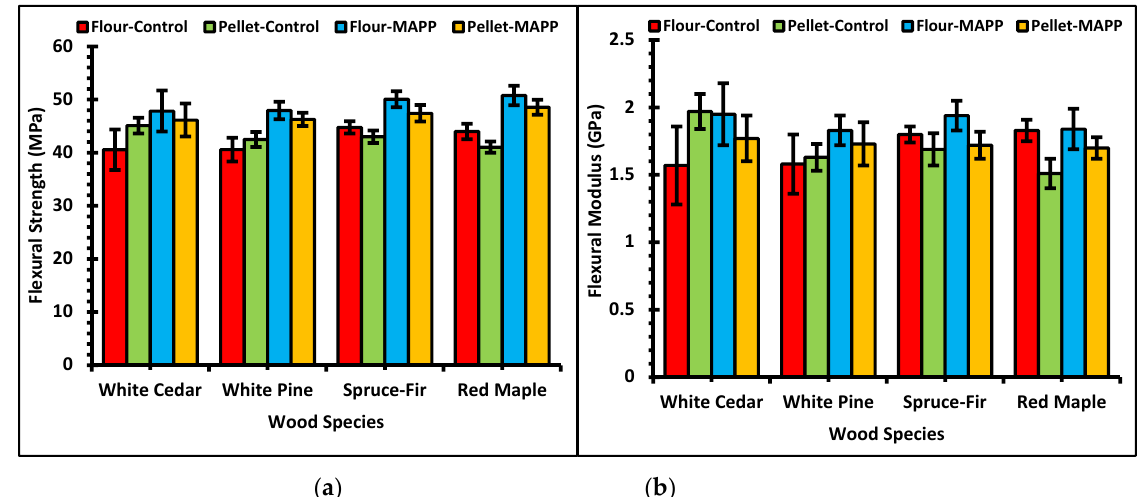
Figure 6. Graphs of ( a ) Flexural strength of WPCs and ( b ) Flexural modulus of WPCs. Typically, the presence of wood fibers in the body of WPCs causes crack initiation and subsequent failure. The graph in Figure 7 show the impact properties of the different WPC samples. Unlike to the tensile and flexural properties, the presence of MAPP did not contribute to a higher impact strength than in the control formulations. Compared to the tensile and flexural properties, the impact strength values for different wood species had a greater variance from the mean value. On average, WPCs of red maple showed better impact strength than the other wood species. The study conducted by Bledzki and Faruk [60], on the effect of wood filler geometry on the physico-mechanical properties of PP/wood composites, reported hardwood flour reinforced PP composites had a better impact strength than the other PP composites of different fillers (softwood fiber, long wood fiber and wood chips). However, higher impact strength of PP based composites for ponderosa pine was greater than the hardwoods: oak and maple [47]. The composite samples made with fine wood particles have poorer impact strength than with coarse-wood particles [61]. In our study, the softwood particles were finer than the hardwood. Because of this, on average WPCs from softwoods had a lower impact strength than the hardwood. Similar to the tensile and flexural values, there was not a difference in the impact values due to the filler type. The average impact strength for the wood flour controls was 8.3% higher than the pellet samples. At flour–controls, it was higher by 14.3% for softwoods and lower by 9.6% for hardwood than the pellet-controls formulation. For the wood flour–MAPP formulations, the impact strength value was 2.3% higher than the pellet MAPP formulations. For softwoods it was higher by 3.7% and for hardwood lower by 1.8% at flour–MAPP formulation than pellet–MAPP formulation. Results of the three-way ANOVA on flexural properties showed the variables alone or their two-way or three-way interactions contribute to some significant differences in the impact properties. did not influence the impact strength with a greater difference. It means in each WPC not have much